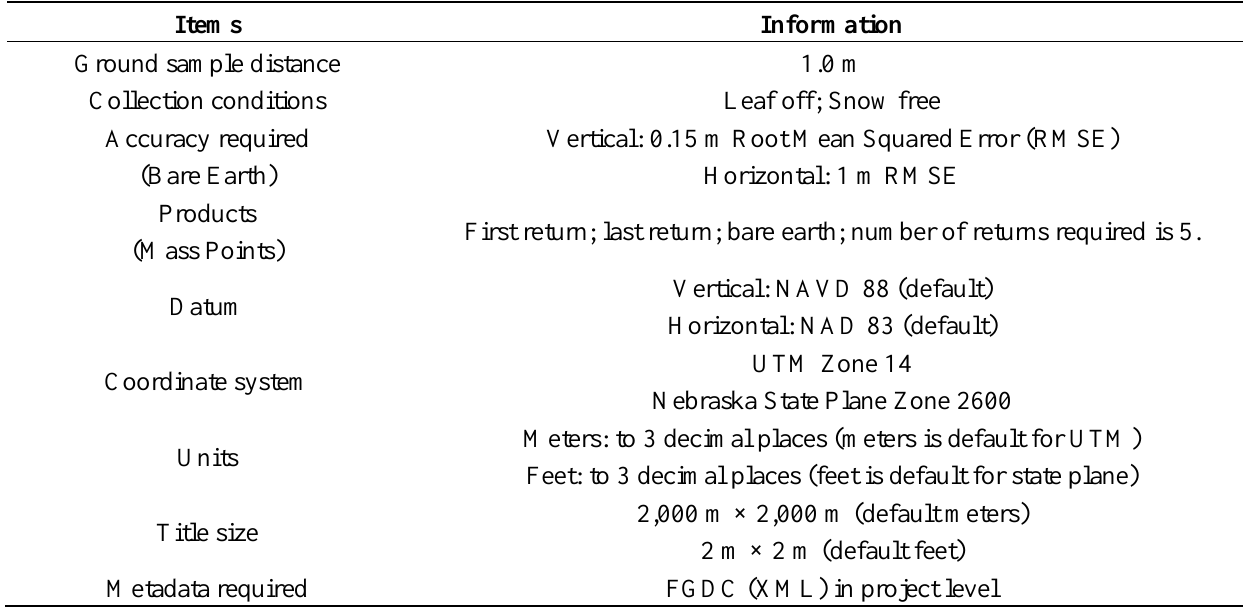
Table 1. Specifications, resolution, and accuracy of Light Detection and Ranging (LiDAR) point clouds